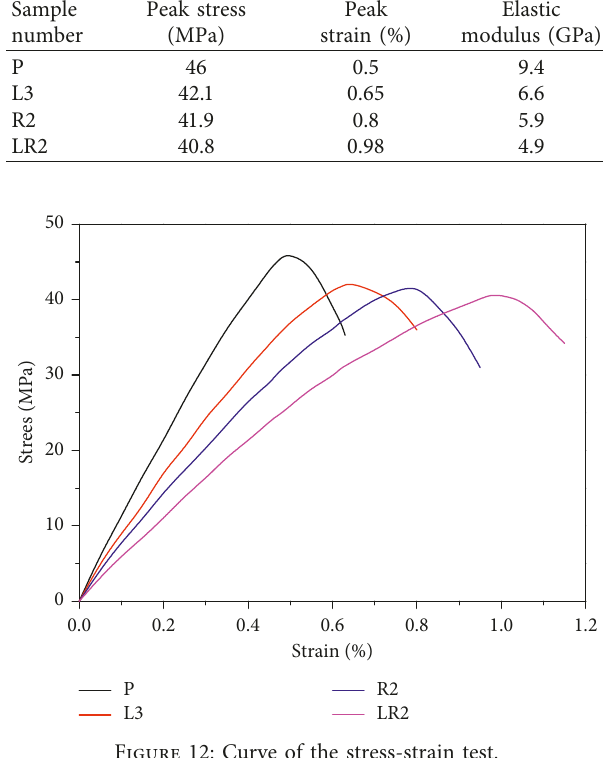
Figure 12: Curve of the stress-strain test.